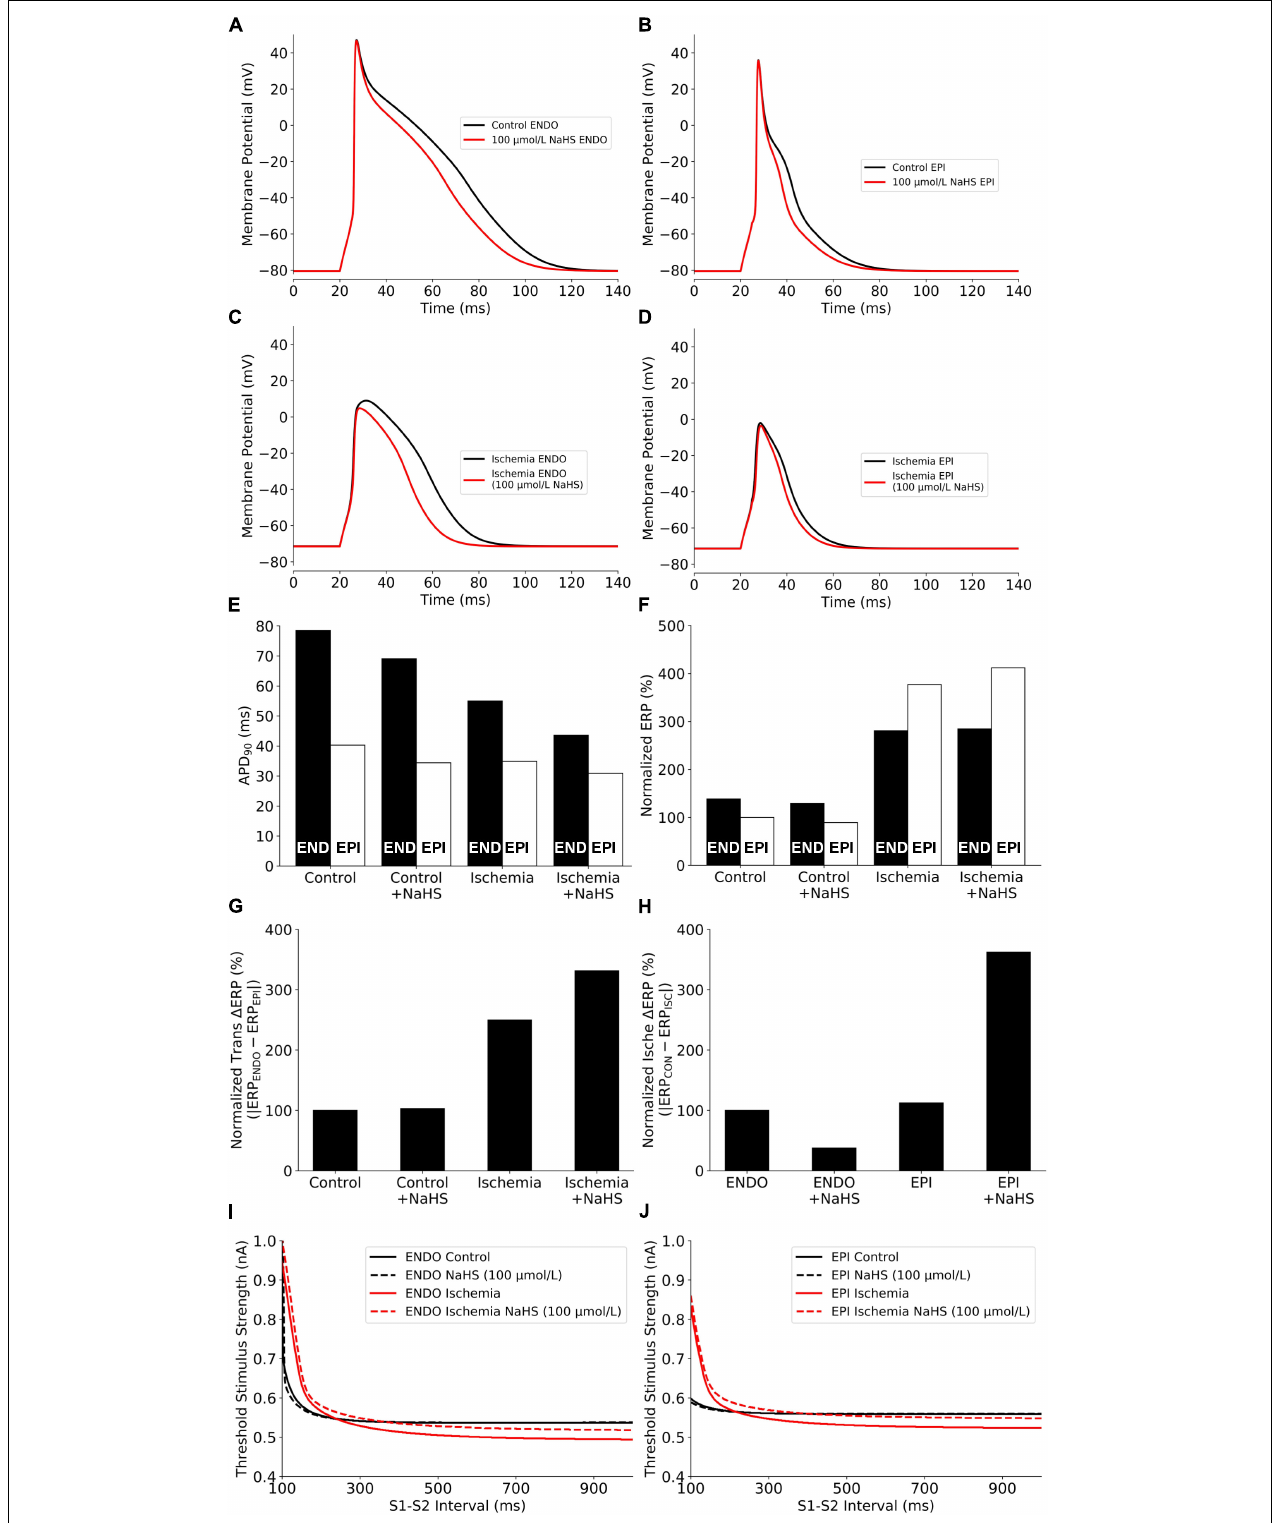
FIGURE 3 | Summary of the effects of NaHS and ischemia on (A–D) AP morphology, (E) APD 90 , (F) Normalized ERP, (G) Normalized ERP transmural gradients between epicardial/endocardial cells, (H) Normalized ERP gradients between ischemic/non-ischemic cells, and (I,J) excitability. AP, action potential; APD, action potential duration; ERP, effective refractory